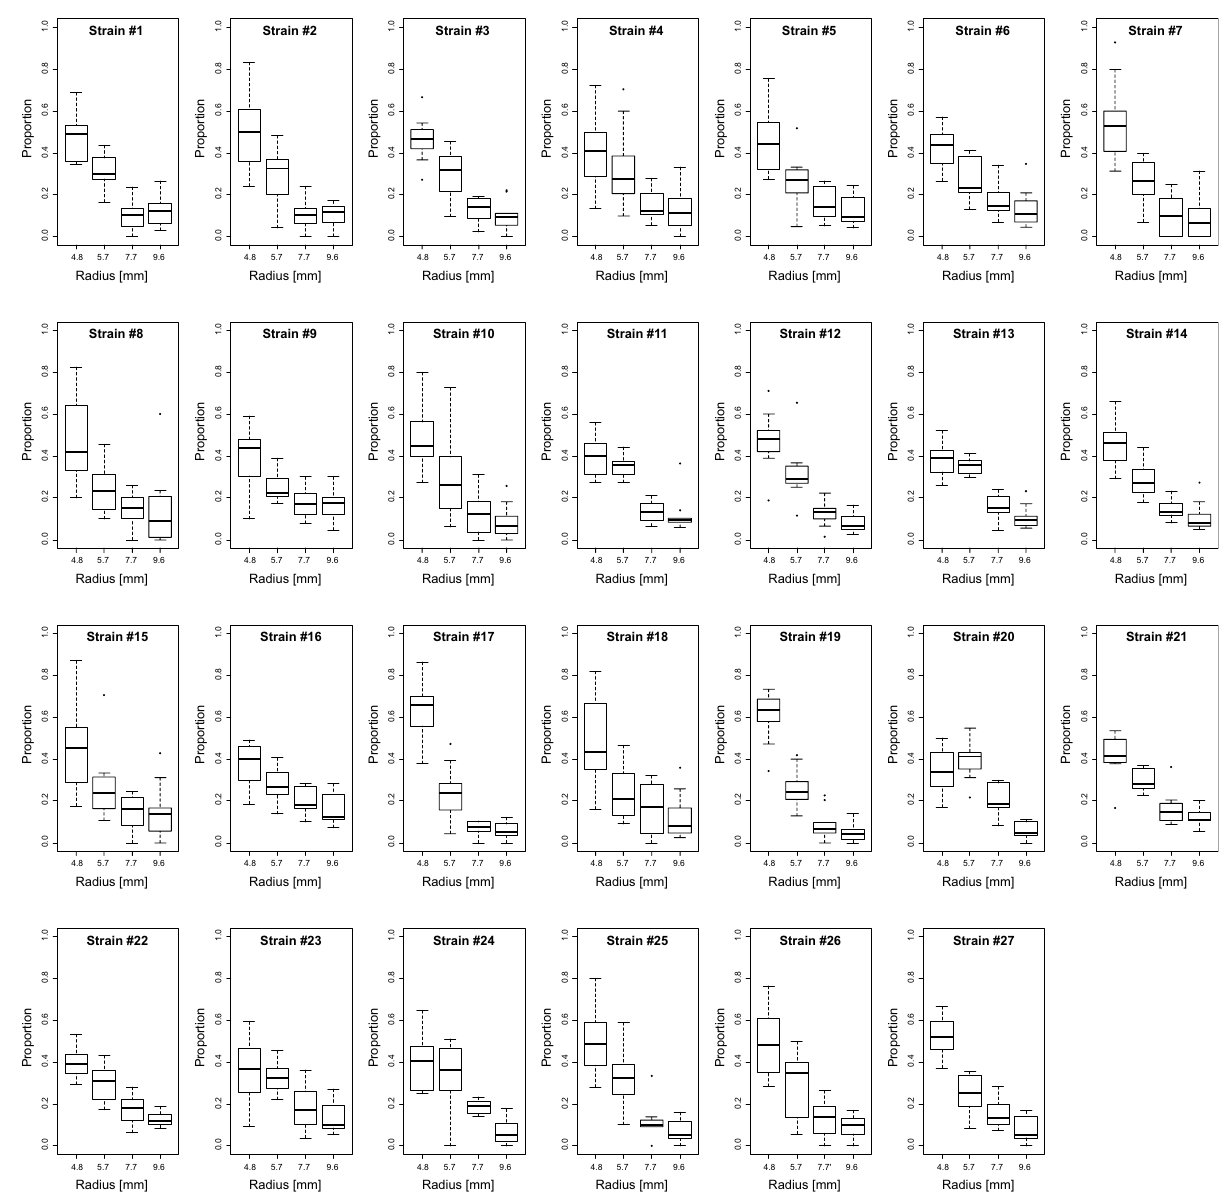
Figure 3. Strain-wise plot of the results of the four-choice assay. Proportion of eggs laid on each size of the oviposition substrate to the total egg number is shown. The assay was repeated for 10 times for each